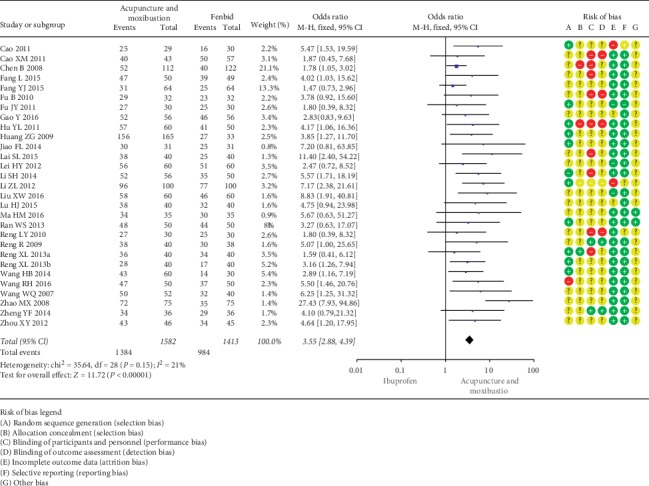
Acupuncture and moxibustion vs. ibuprofen.